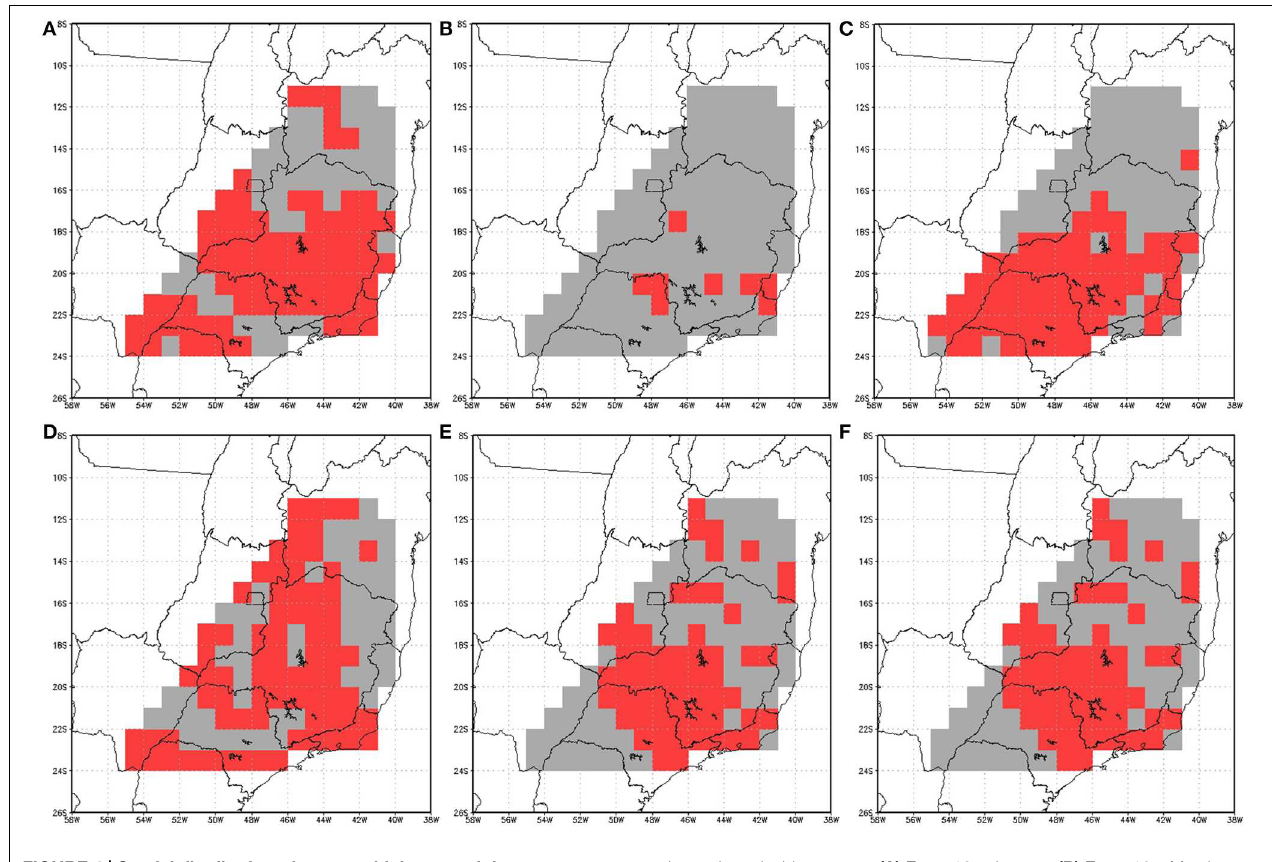
FIGURE 4 | Spatial distribution of events with increased date coincidence between the SACZ and a criterion-selected extreme. The light gray color represents the entire study area and the dark gray color